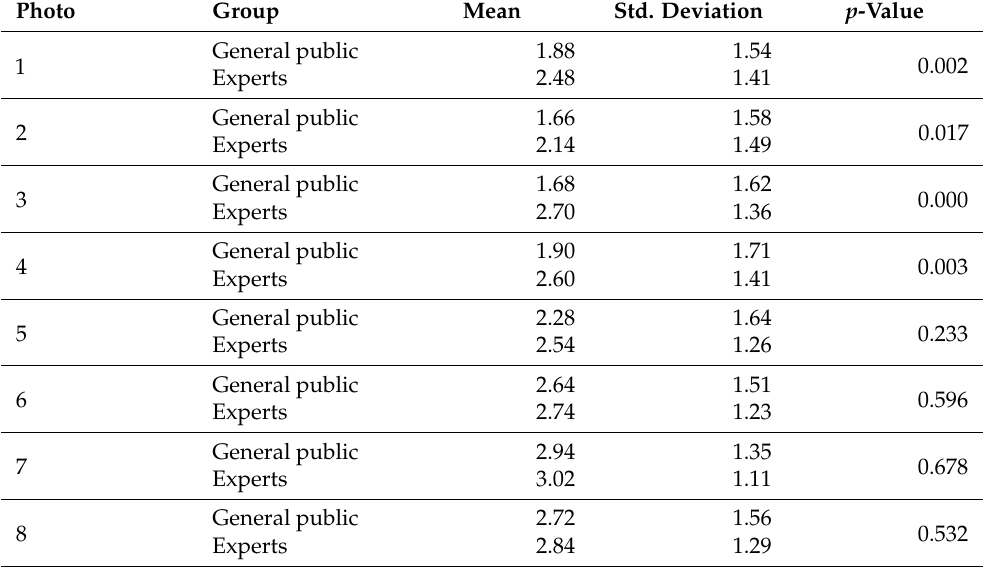
Table 15. Evaluation of safety in close proximity to WT by experts and the public.